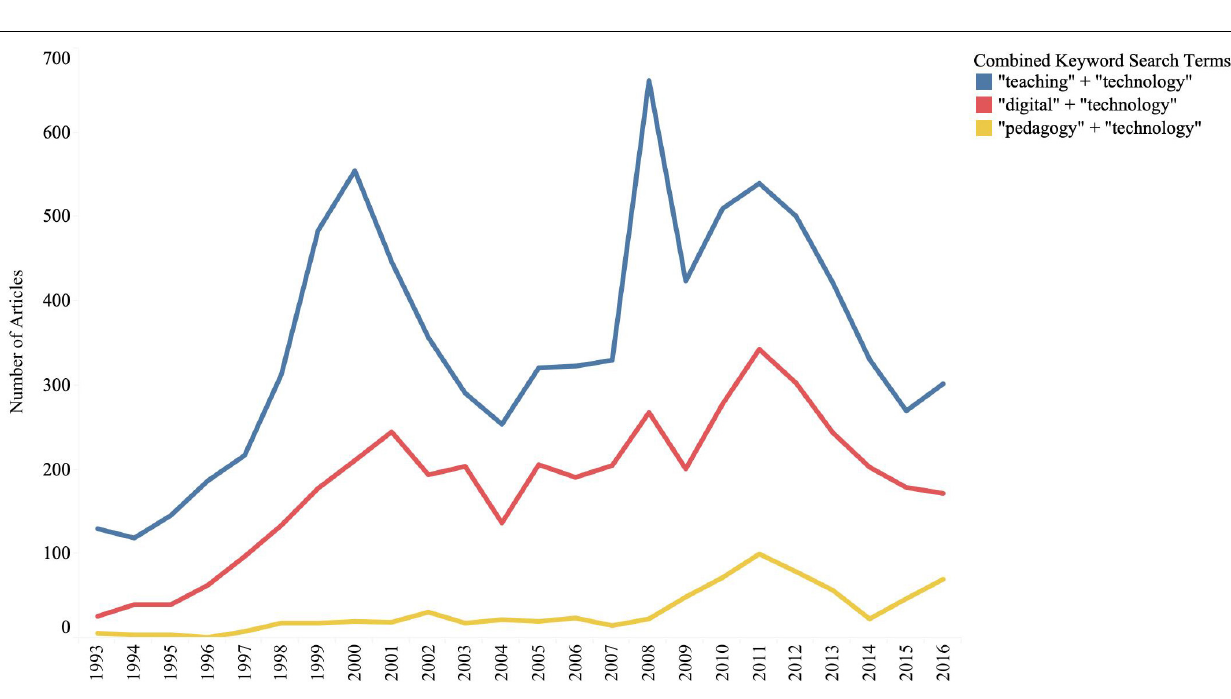
Frontiers in Education |